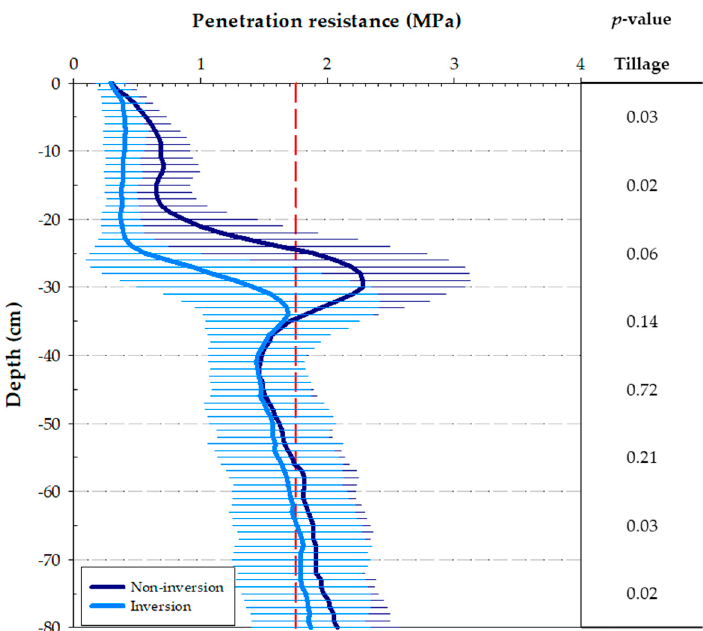
Figure 6. Average penetration resistance (MPa) ± standard deviation ( n = 165) between 0 and 80 cm depth after tillage (non-inversion: dark blue; inversion: light blue), but before experimental traffic. The red dashed line represents the threshold values for sugar beet root growth (1.75 MPa).